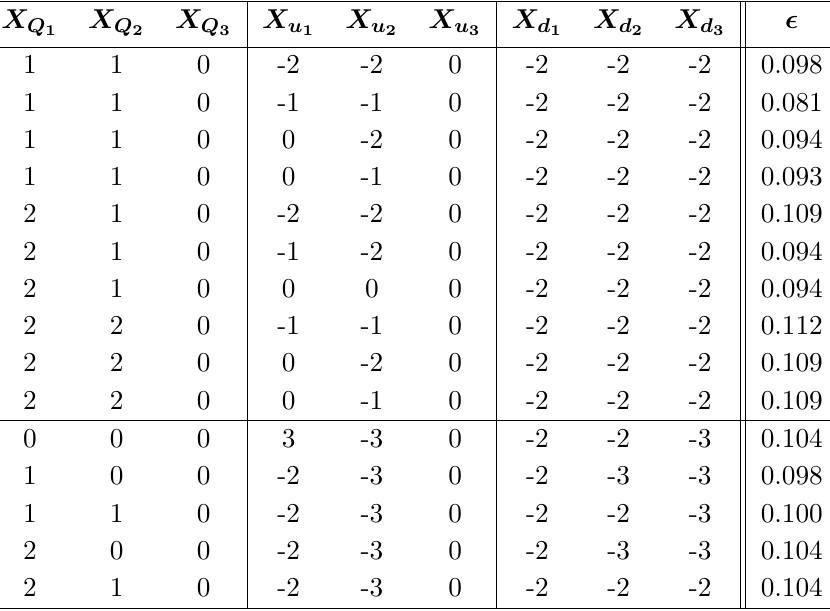
Table 2 . A selection of viable FN models characterized by a larger expansion parameter, (cid:15) Similarly to what already done for table 1, here we report in the (cid:12)rst 10 lines some of the